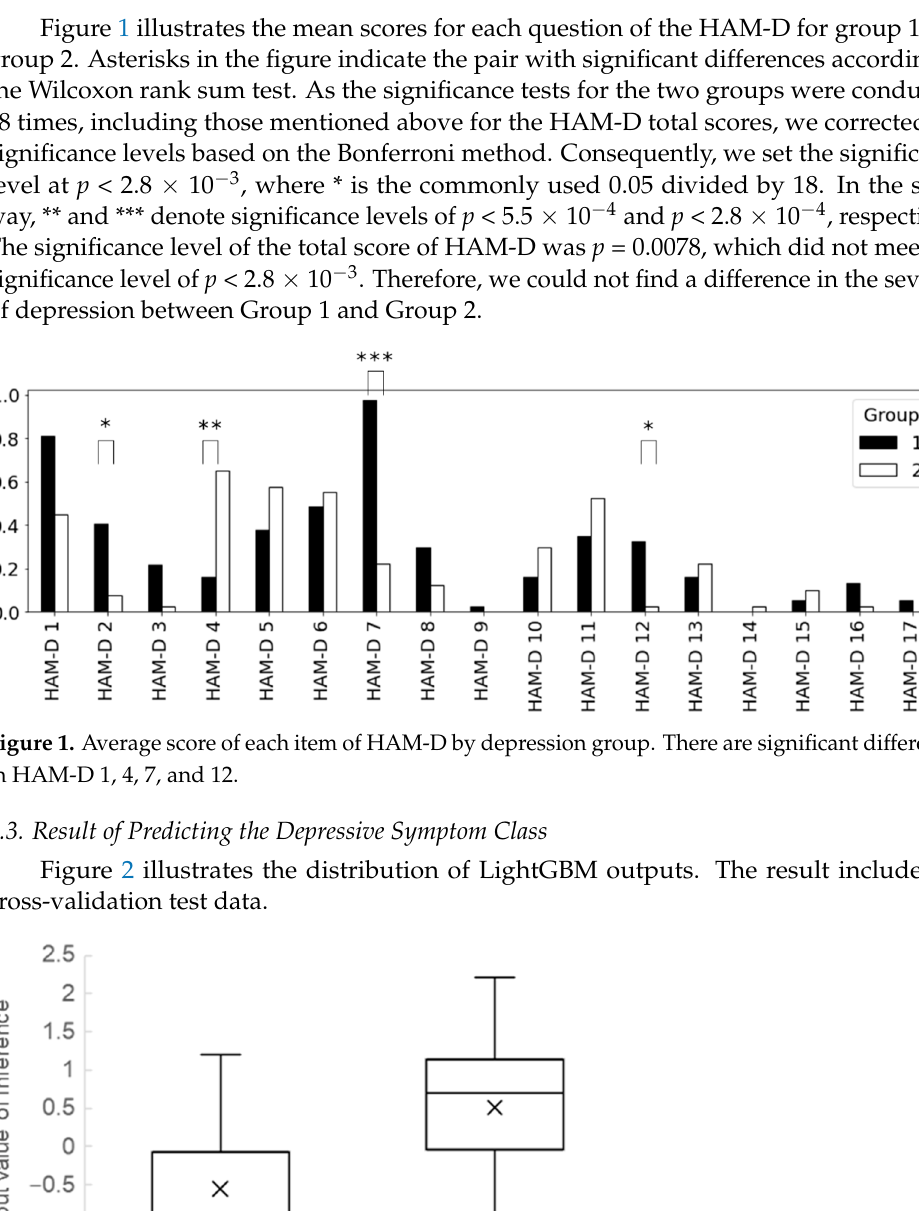
Table 7. Accuracy of decision trees. n = 77